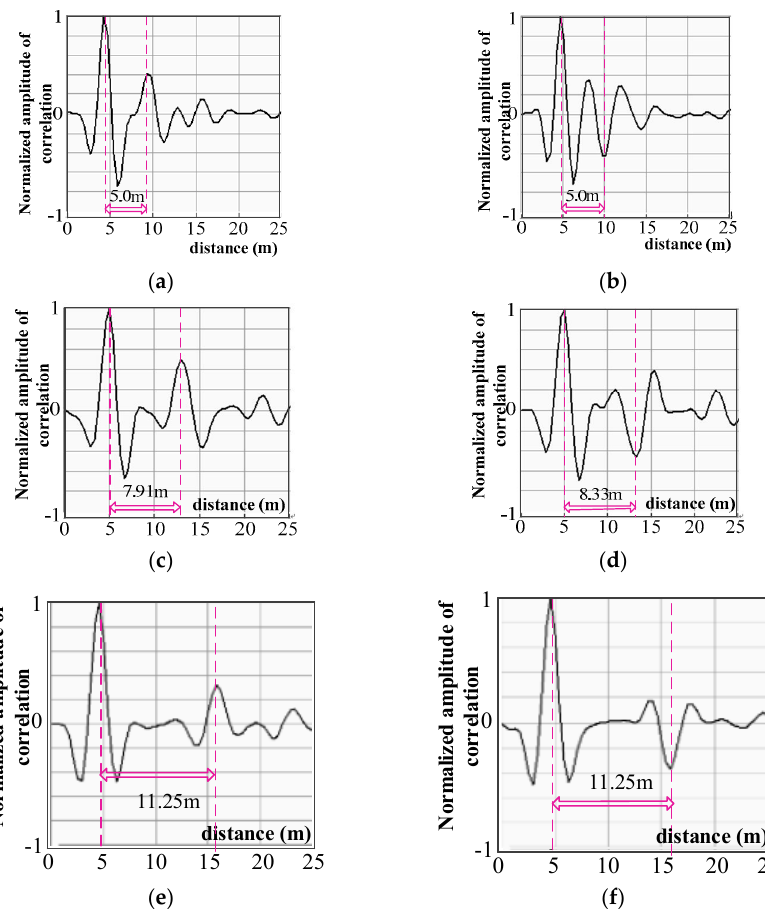
Figure 11. Experimental diagram of inductive directional non-intrusive coupled cable fault diagnosis. ( a ) open circuit of 4.75 m; detected location is 5 m and error is 0.25 m; 167% larger than 2nd largest peaks. ( b ) short circuit of 4.75 m; detected location is 5 m and error is 0.25 m; 66.6% larger than 2nd largest peaks. ( c ) open circuit of 8.10 m; detected location is 7.91 m and error is 0.19 m; 212% larger than 2nd largest peaks. ( d ) short circuit of 8.10 m; detected location is 8.33 m and error is 0.23 m. 156% larger than 2nd largest peaks. ( e ) open circuit of 11.0 m; detected location is 11.25 m and error is 0.25 m; 357% larger than 2nd largest peaks. ( f ) short circuit of 11.0 m; detected location is 11.25 m and error is 0.25 m. 500% larger than 2nd largest peaks.